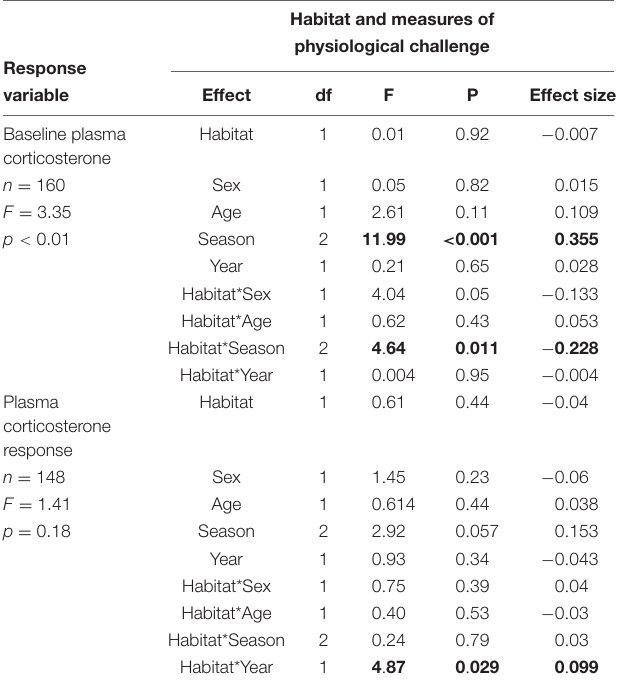
TABLE 3 | Final model testing the influences of habitat baseline concentrations of corticosterone, and changes in concentrations of circulating corticosterone in response to the stress of